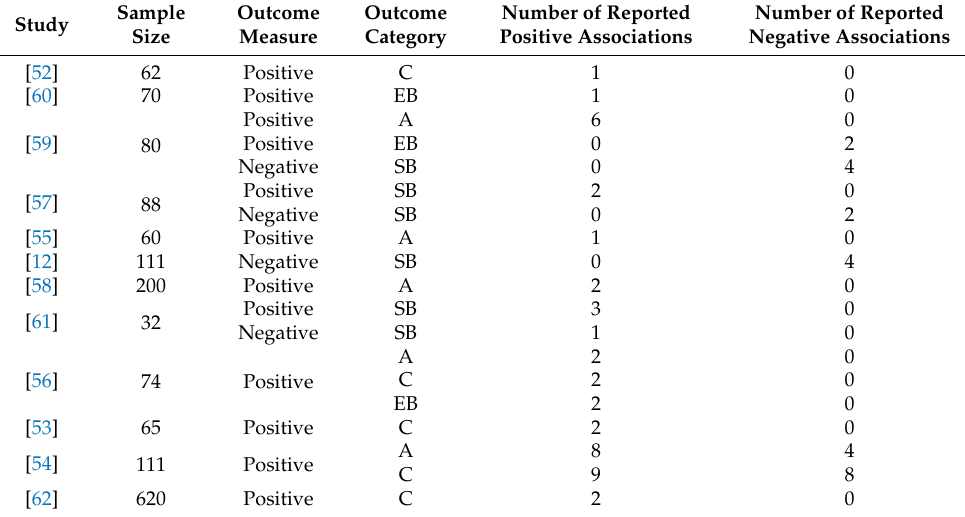
Table 9. Toy play—outcome measure descriptions and results